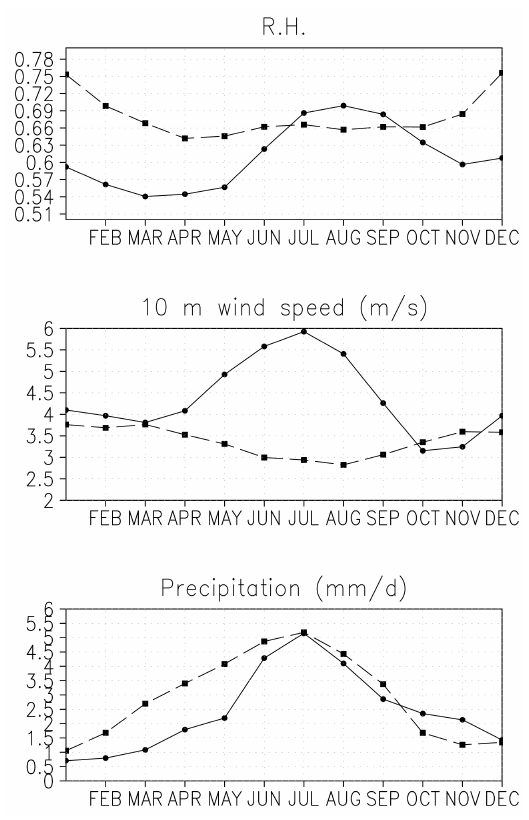
Fig. 12. Monthly mean RH, 10-m wind speed and precipitation for China (dashed line) and India (solid line), four-year average (2006– 2009 Fig. 14. AOD in Kanpur from AERONET point measurement in year 2006 at λ = 500nm (black) and as a grid box four-year average from ECHAM5-HAM data using 2006 emissions at λ = 550nm (grey).